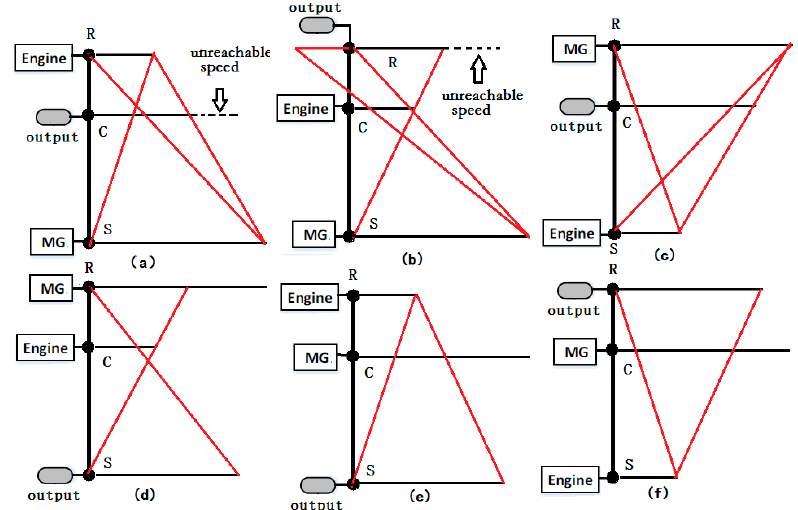
Figure 5. Speed relationship when engine, output, and motor are connected in one PG. ( a ) engine at the ring gear, output at the carrier gear, motor at the sun gear; ( b ) engine at the carrier gear, output at the ring gear, motor at the sun gear; ( c ) engine at the sun gear, output at the carrier gear, motor at the ring gear; ( d ) engine at the carrier gear, output at the sun gear, motor at the ring gear; ( e ) engine at the ring gear, output at the sun gear, motor at the carrier gear; ( f ) engine at the sun gear, output at the ring gear, motor at the carrier gear.